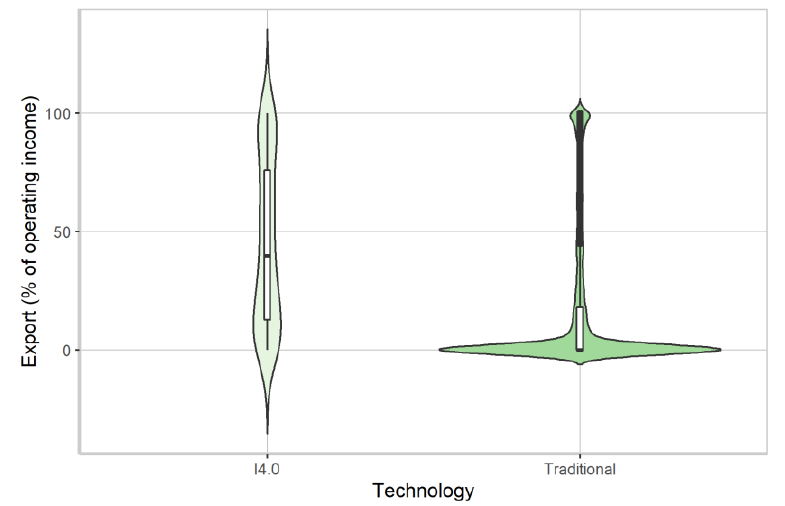
Figure 9. Distribution of the marginal rate of technical substitution (MRTS).